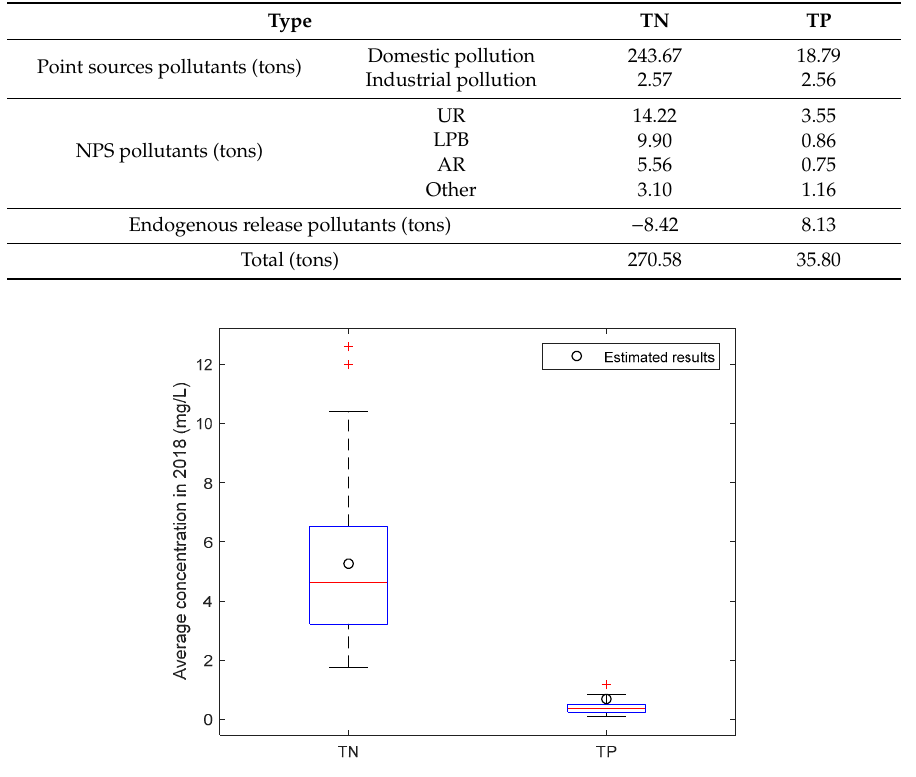
Figure 5. Annual average TN and TP concentrations observed in 2018 .